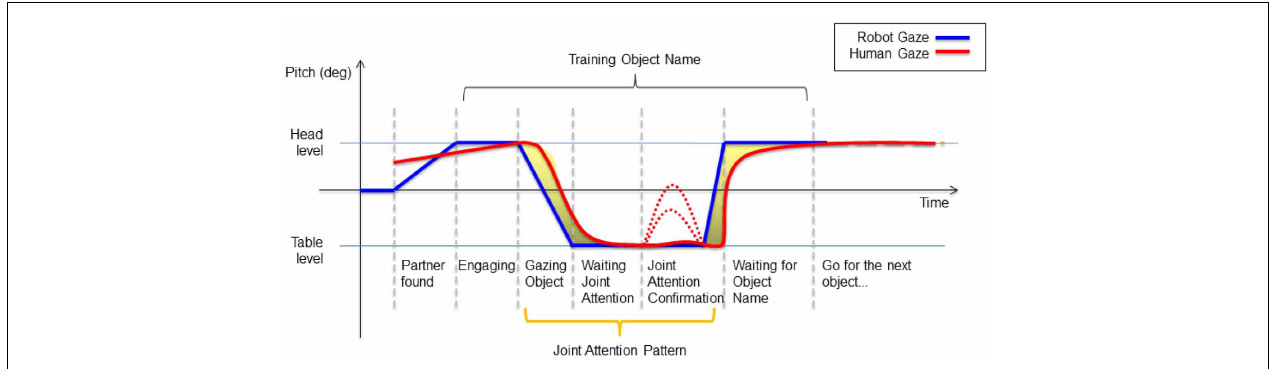
FIGURE 5 | Ideal timeline for the human’s and robot’s gaze during the teaching phase of the experiment, in the RI condition. The robot gaze (blue line) is moved toward the human head to look for eye contact. When mutual eye contact is established, in the RI condition the robot lowers the head to